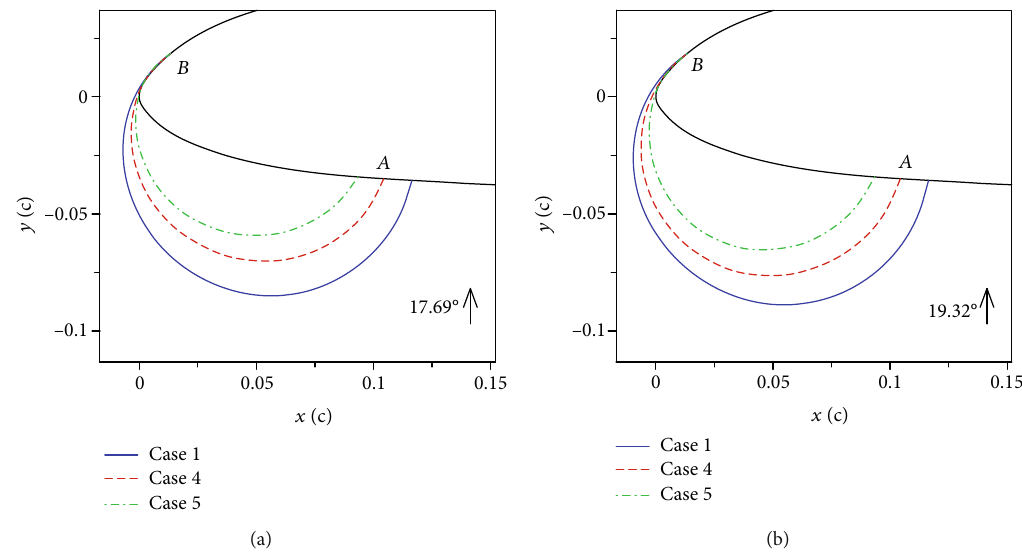
Figure 25: Comparison of ILE shapes at angles of attack of 17.69 and 19.32deg upstroke for Cases 1, 4, and 5.